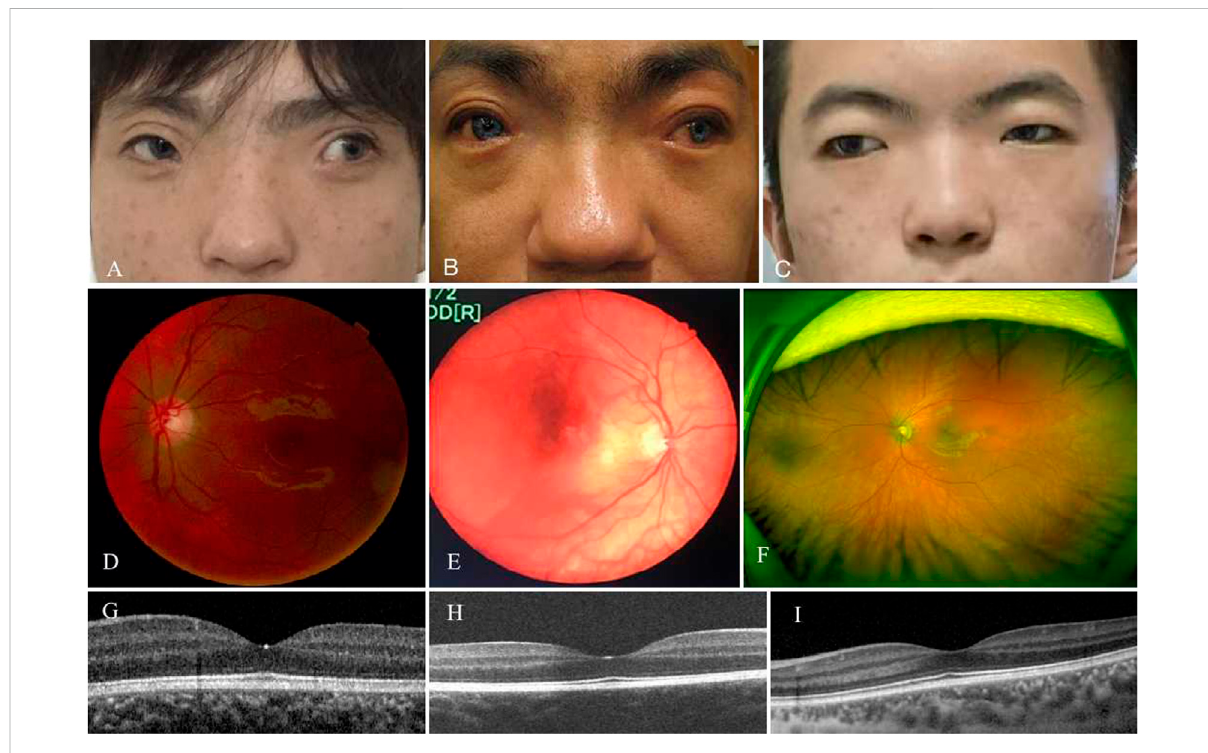
FIGURE 1 Phenotypes of three patients with WS and exotropia. All patients had an large angle exotropia (A – C) . They were diagnosed as WS by dystopia canthorum, broad nasal root, synophrys (A – C) , and hypopigmented fundus (D – F) . Their fovea structure were normal (G – I)